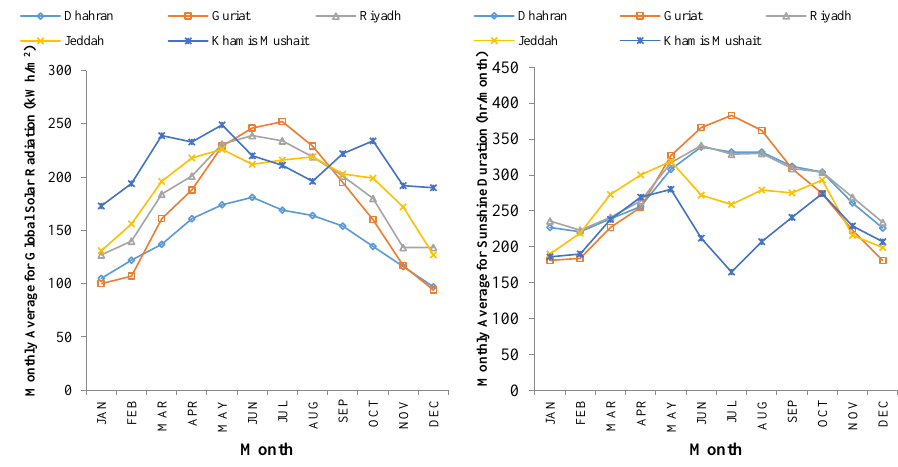
Figure 7. The monthly global solar radiation in the five main climatic zones of Saudi Arabia [61].